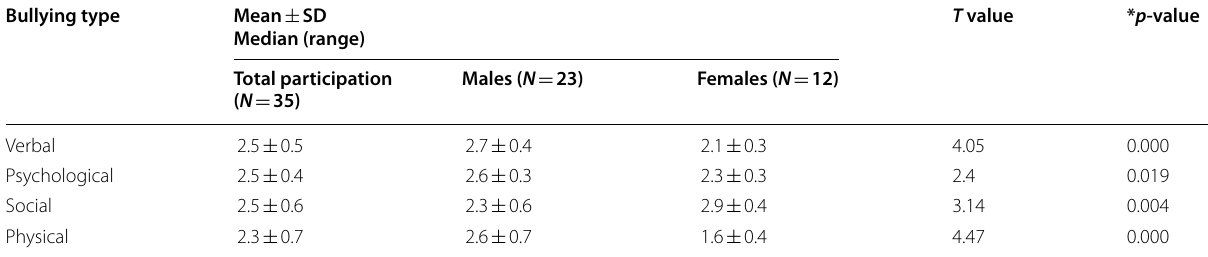
* P value calculated by Mann–Whitney test